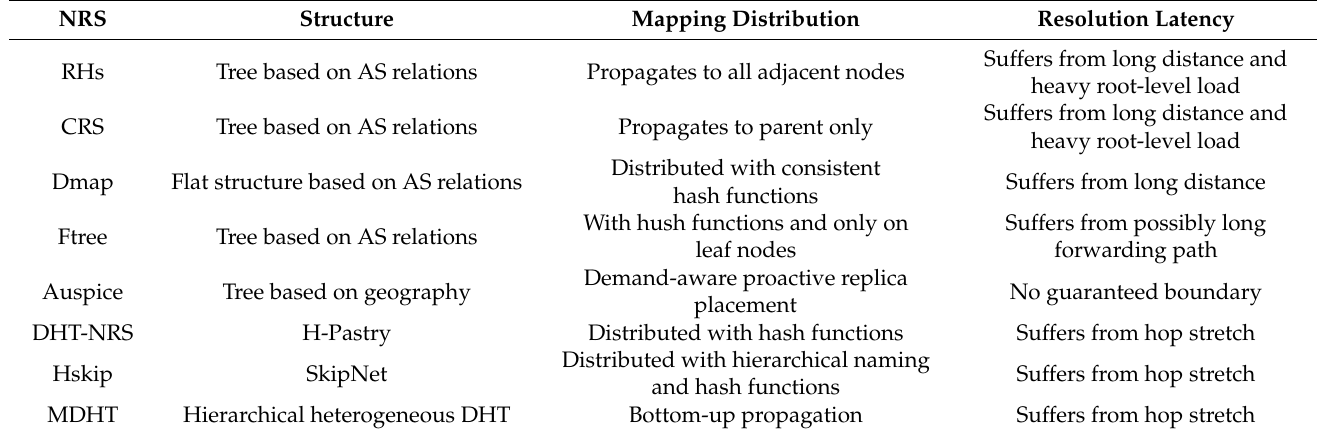
Table 1. The comparison of different ICN